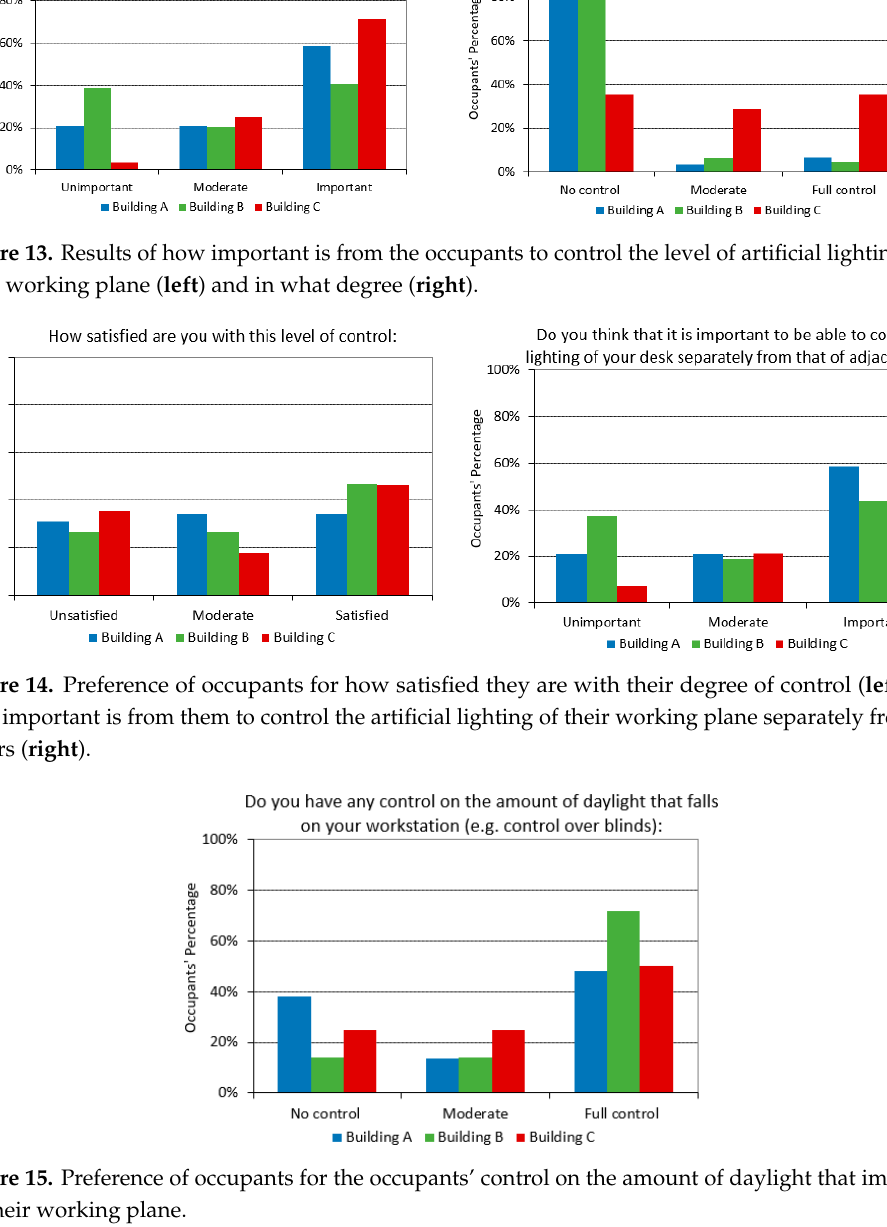
Figure 15. Preference of occupants for the occupants’ control on the amount of daylight that impinges on their working plane.